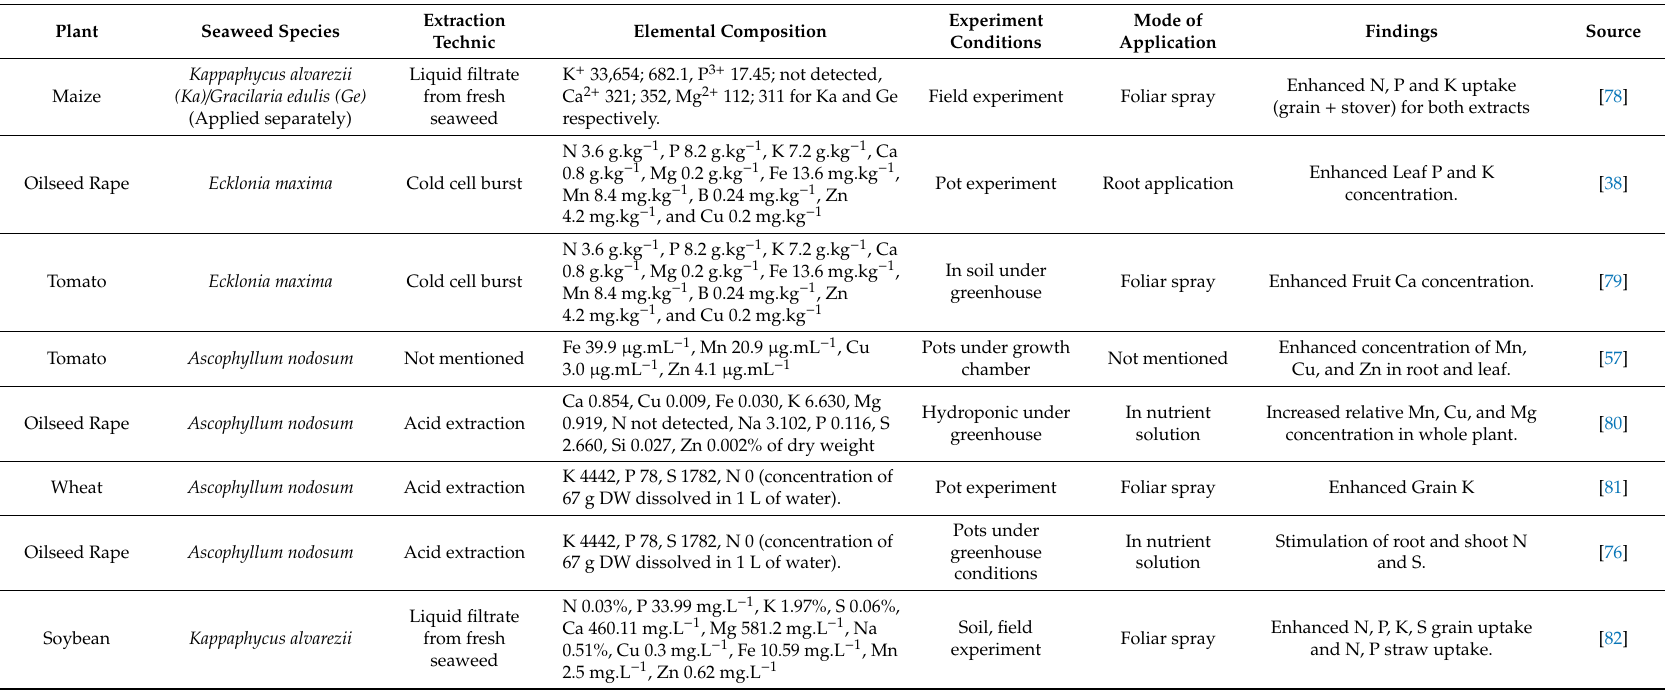
Table 1. E ff ect of seaweed extracts on plant nutrient uptake and